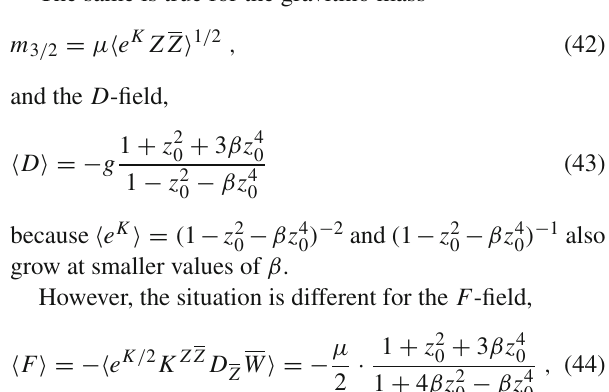
as well as the supersymmetry breaking parameters (cid:7) F (cid:8) and (cid:7) D (cid:8) given by Eqs.(67) and (68) in Appendix. The results